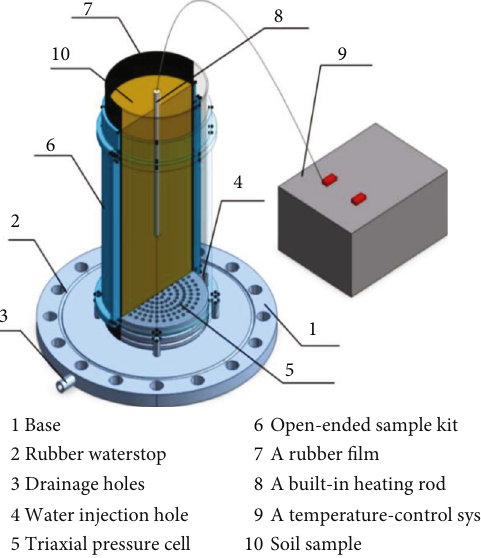
Figure 4: Heating device for the samples.